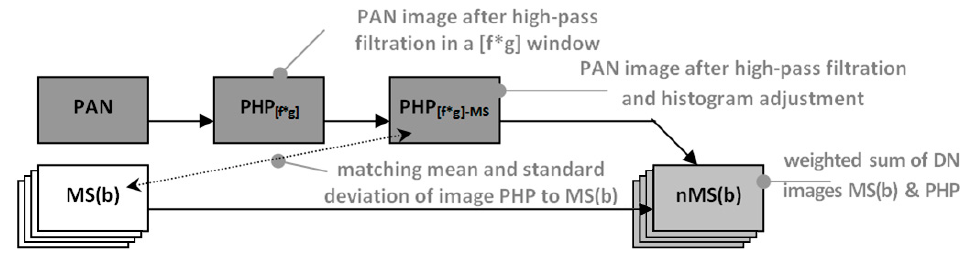
Figure 4. Diagram of the spatial enhancement procedure using the high ‐ pass filter (HPF) method.